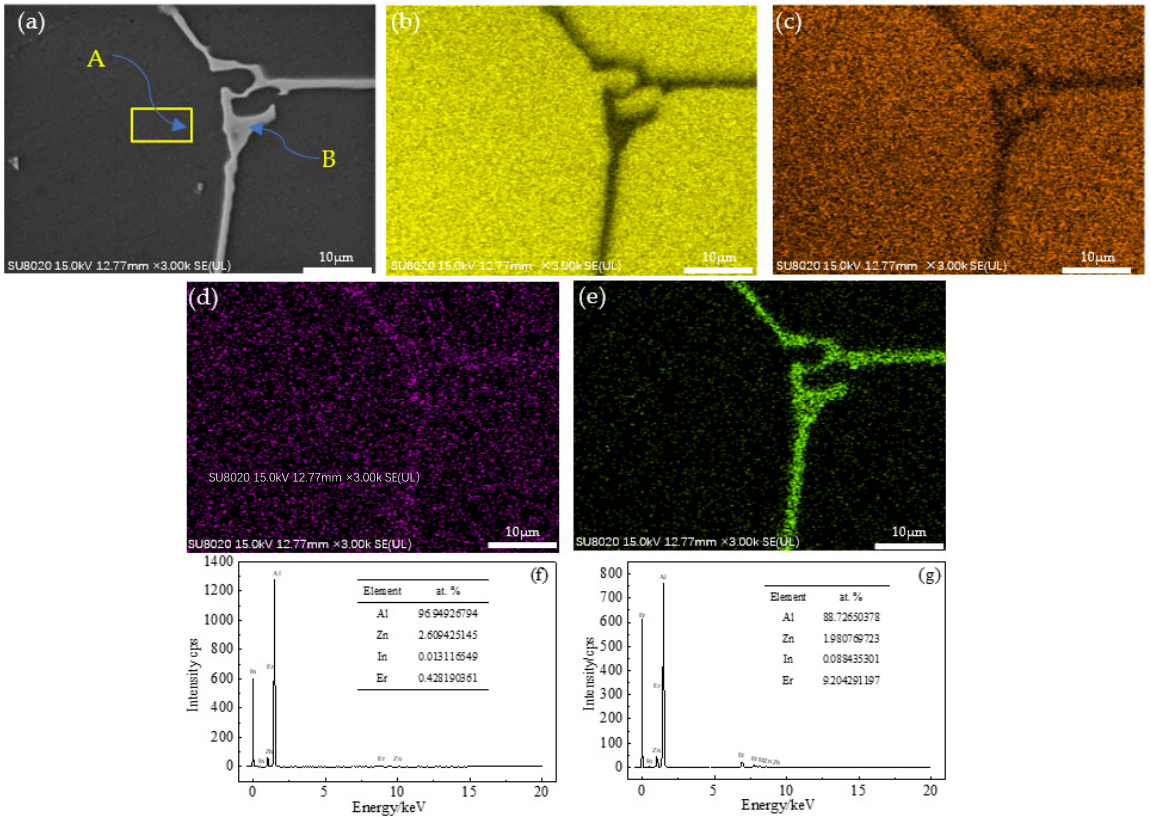
Figure 4. Microstructure and the main element distribution in the as-cast Al-Zn-In-Er alloy. ( a ) SEM image, ( b ) Al, ( c ) Zn, ( d ) In, ( e ) Er, ( f ) EDS of Point A, ( g ) EDS of Point B.